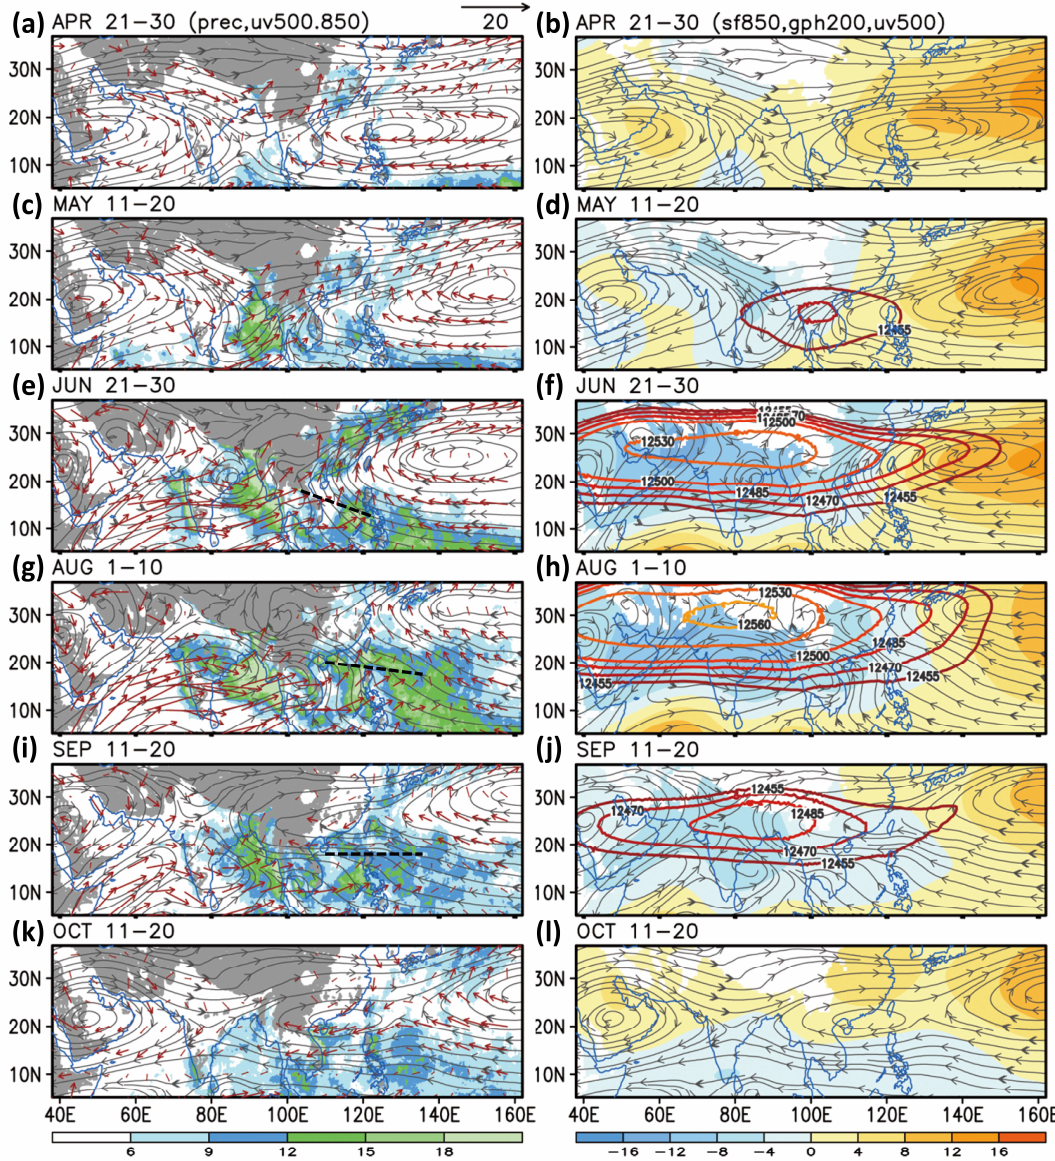
Figure 4. (Left) Precipitation (mm day −1 ; shadings), 500–hPa streamlines, and 850–hPa winds (m s −1 ; red vectors for wind speeds higher than 3 m s −1 ). Gray shading denotes elevation higher than 0.6 km. (Right) The 850–hPa streamfunction (10 6 m 2 s −1 ; shadings), 500–hPa streamlines, and 200–hPa geopotential heights (contour lines for heights greater than 12,455 gpm). The averaged periods are ( a , b ) 21–30 April; ( c , d ) 11–20 May; ( e , f ) 21–30 June; ( g , h ) 1–10 August; ( i , j ) 11–20 September; and ( k , l ) 11–20 October. Dashed lines denote the Western North Pacific (WNP) monsoon trough.